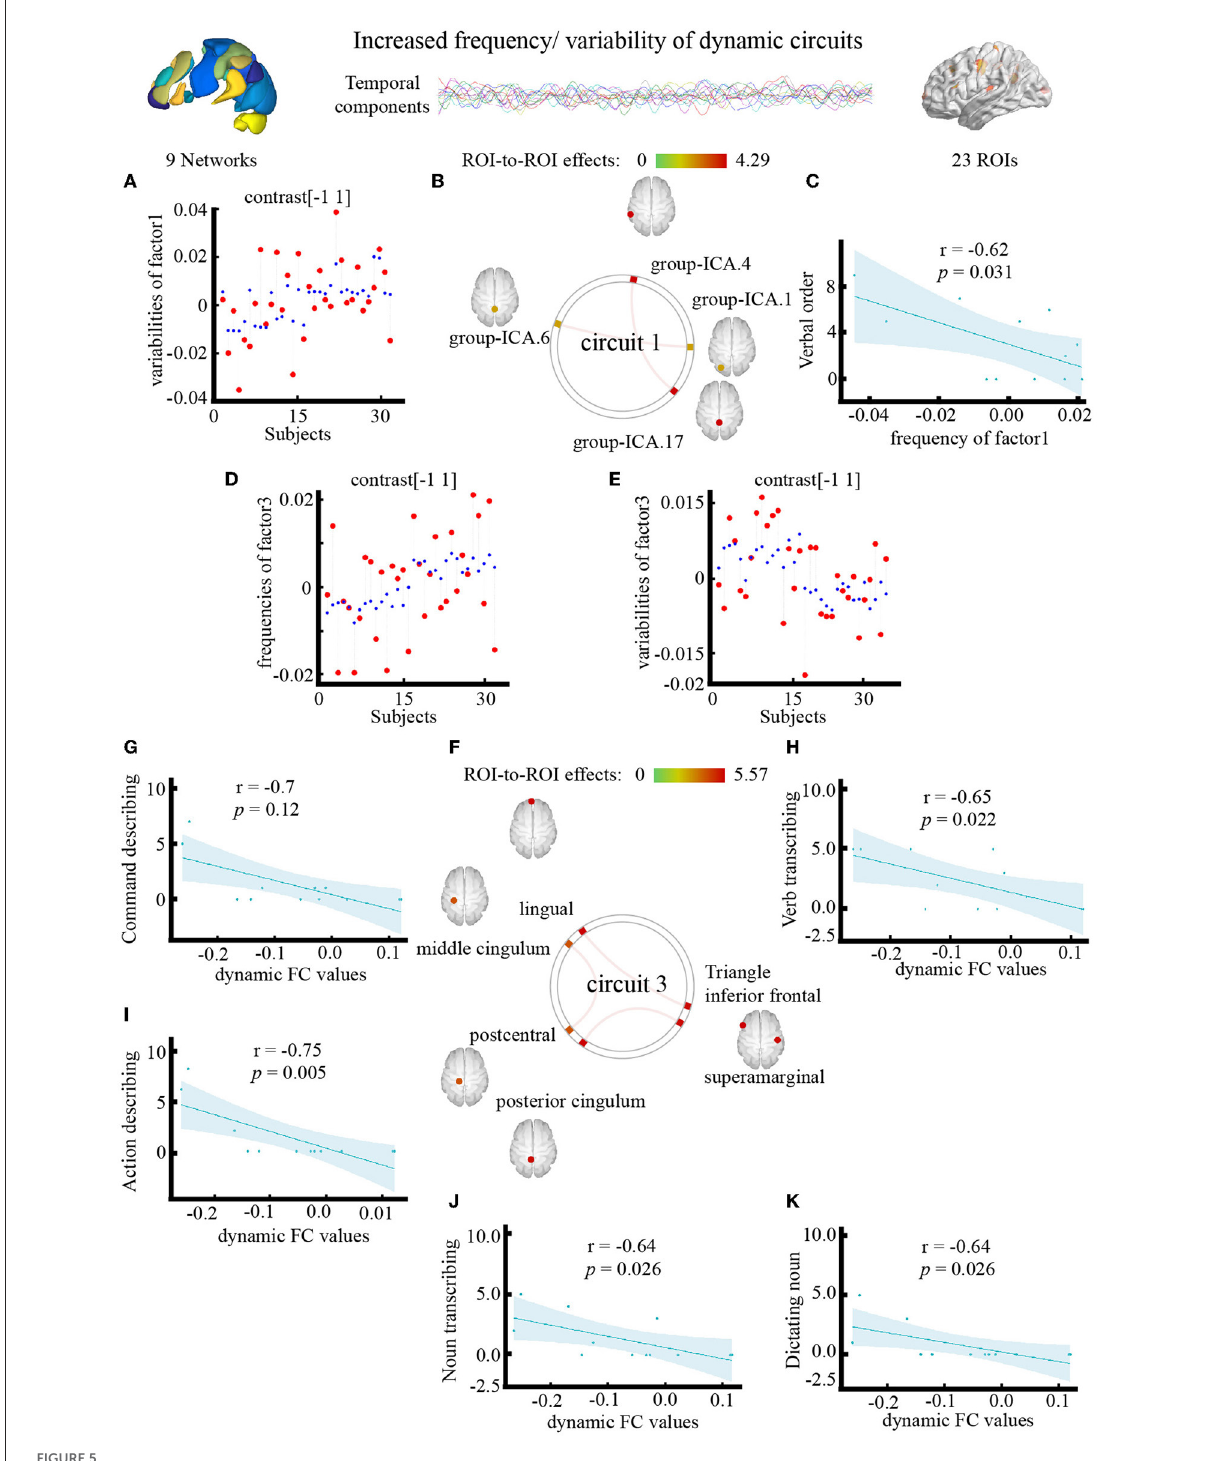
FIGURE5 Effect of electroacupuncture (EA) stimulation on dynamic independent component analysis. (A) Changes in temporal properties varies of circuit1. (B) Spatial map of circuit1 for the contrast of condition main effect. (C) Correlation between frequency of circuit1 and clinical parameter (CRRCAE score). (D,E) Changes in temporal properties varies of circuit3. (F) Spatial map of circuit3 for the contrast of condition main effect. (G–K) Correlation between clinical parameter (CRRCAE score) and dynamic FC values of triangle inferior frontal and lingual.